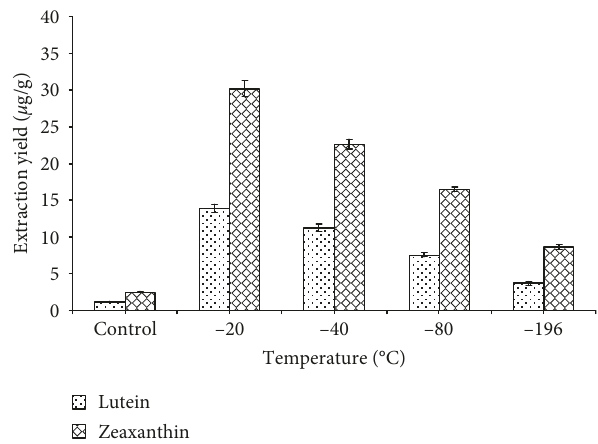
Figure 2: Effect of FT temperature on extraction yield of